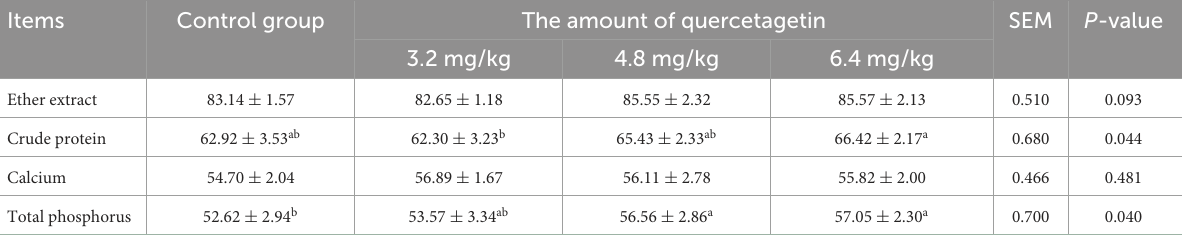
TABLE 3 Effect of quercetagetin on apparent metabolic rate of nutrients in broilers